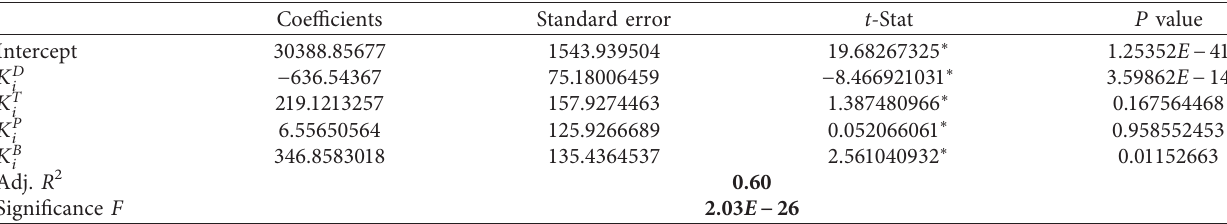
Figure 7: Local spatial autocorrelation analysis of housing price (2015). (a) LISA aggregation chart. (b) Moran scatter chart. Table 4: Results of regression model